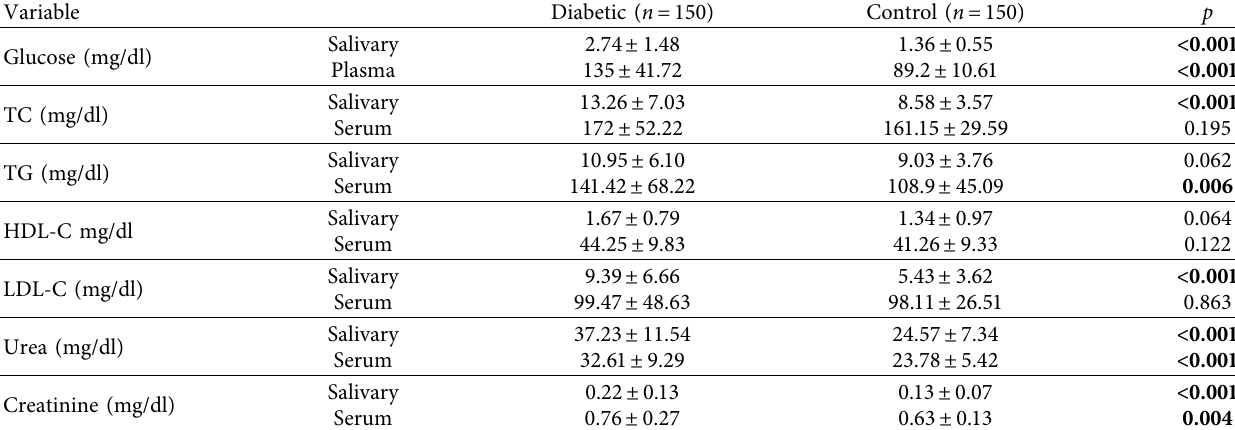
Table 3: Mean comparison of salivary and blood biochemical parameters between patients with DM and control group.